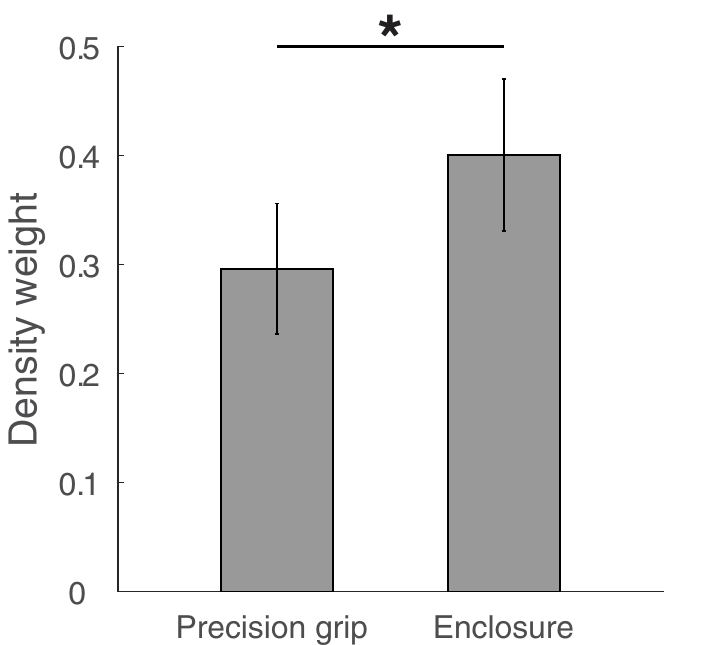
Fig 5. Density weights in Experiment 2. Fitted density weights for the precision grip and the enclosure condition. Weights are averaged over individual participants with error bars denoting the 95% confidence interval of between- participant